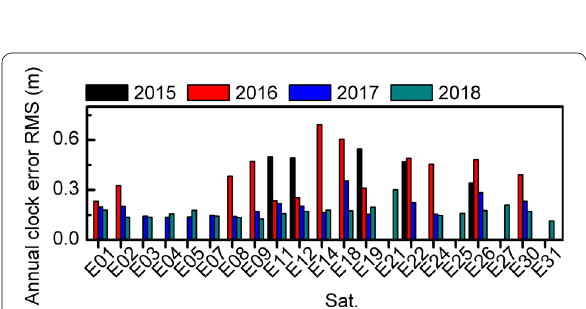
Fig. 7 Satellite-specific clock RMS errors for all Galileo satellites